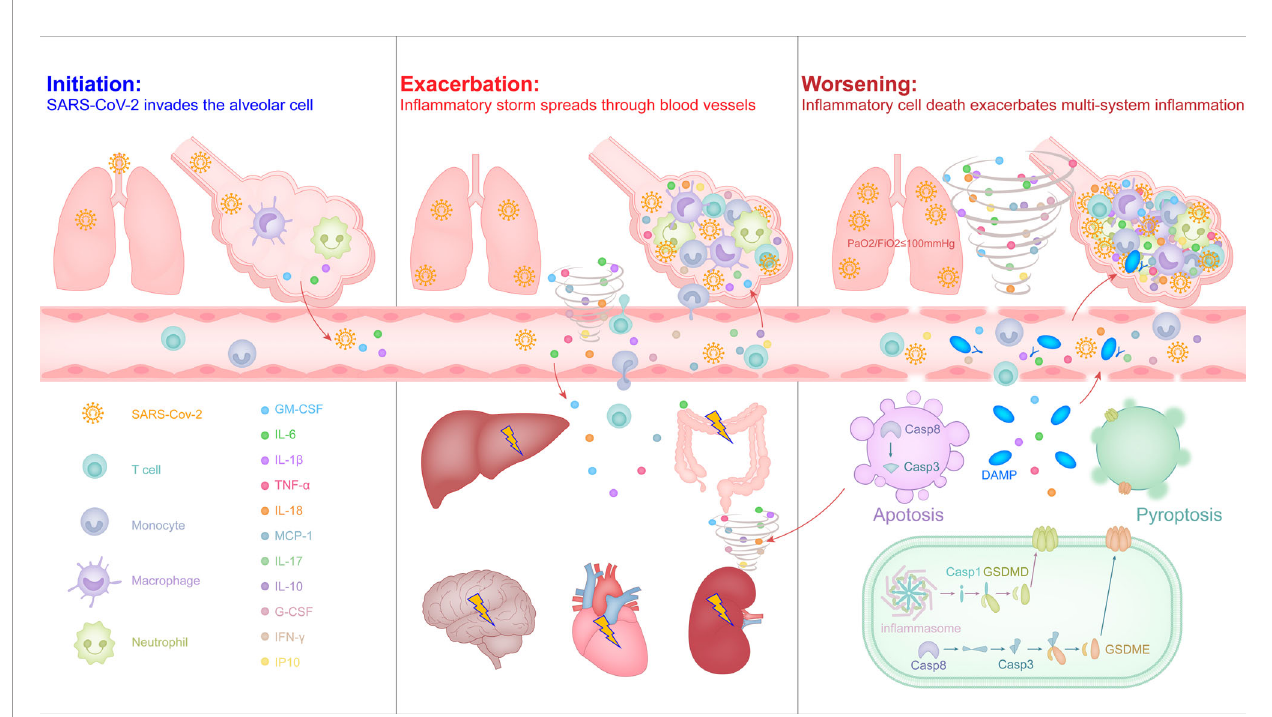
FIGURE 1 | The malignant cycle of in fl ammatory factors and in fl ammatory cell death exacerbates the in fl ammatory storm to trigger ARDS and multiorgan failure in severe